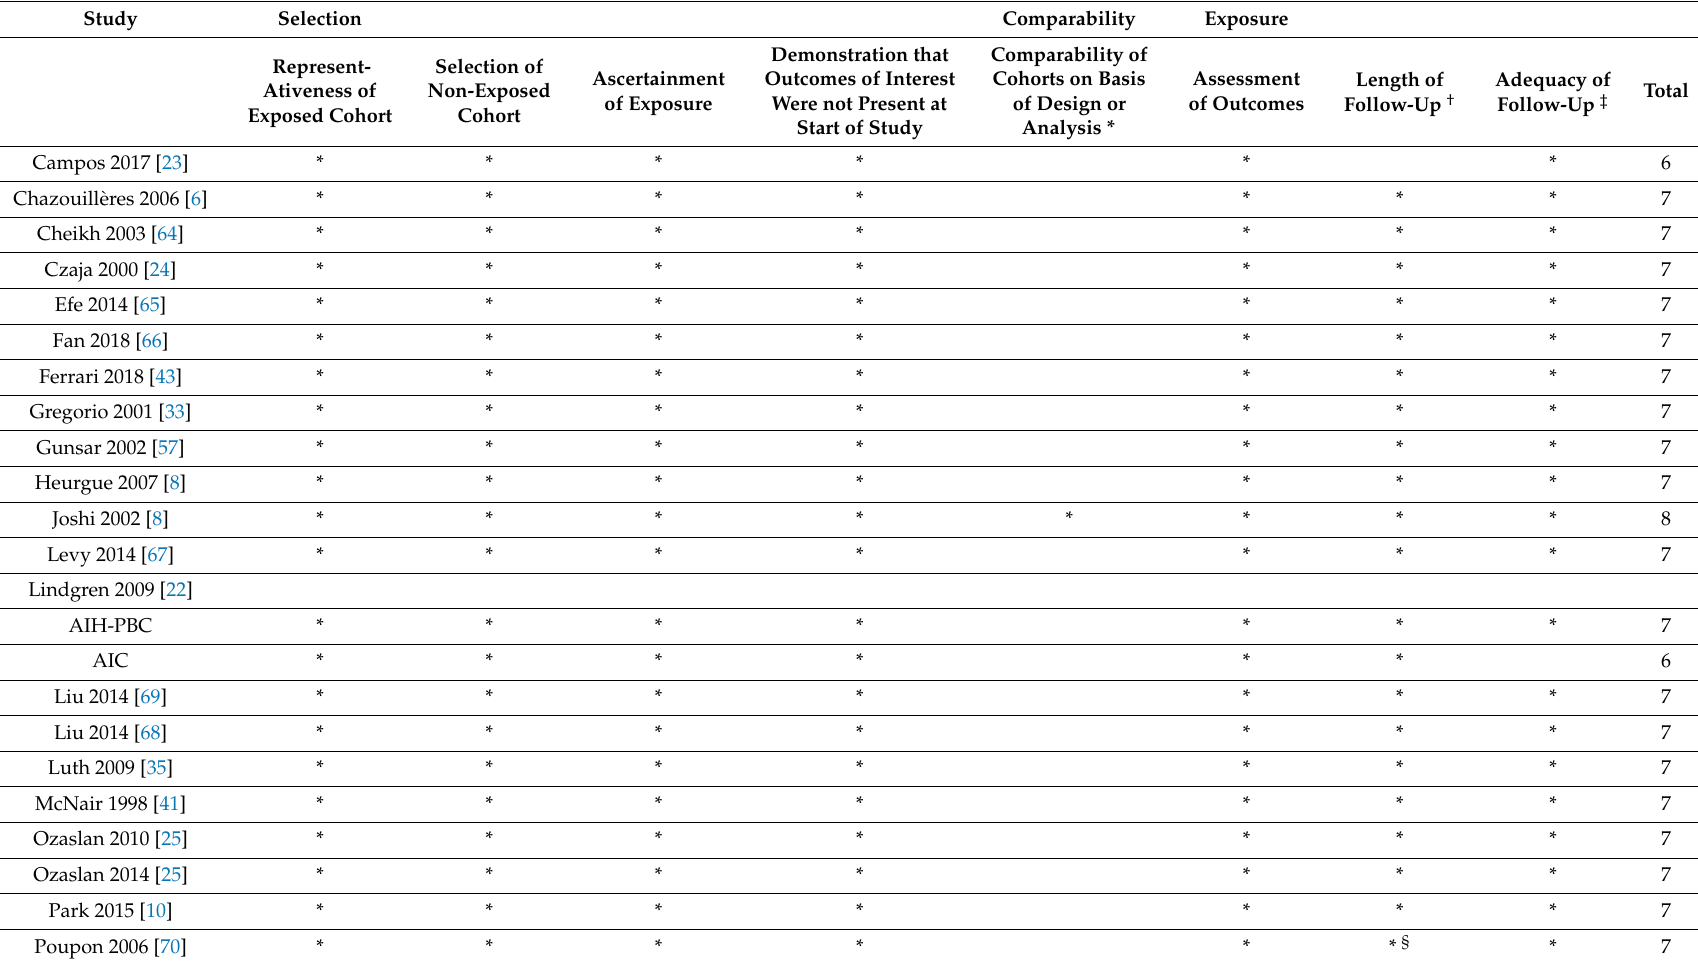
Table 2. Quality of studies included in systematic review as quantified by Newcastle–Ottawa